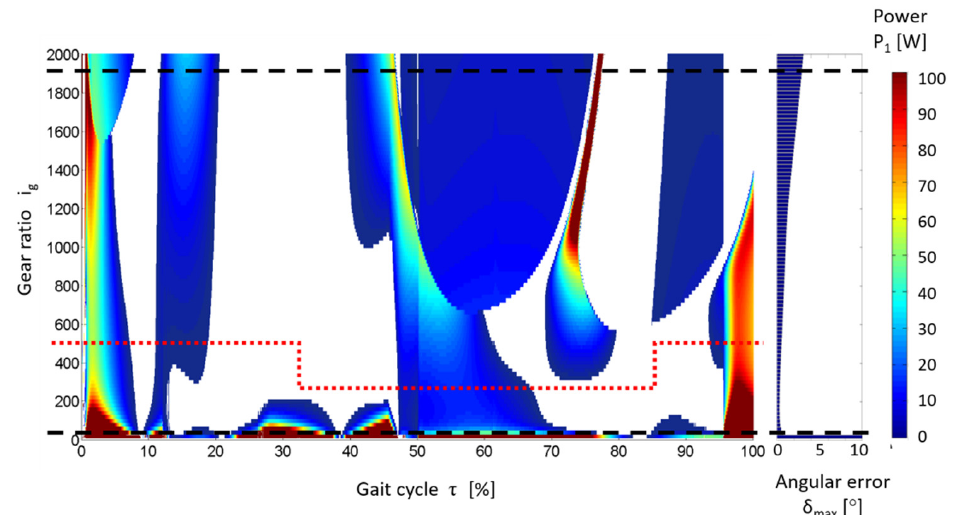
Figure 19. Graph of the instantaneous energy demand at the knee joint and the maximum profile error for the tested gear ratios when performing steps of 0.7 m.